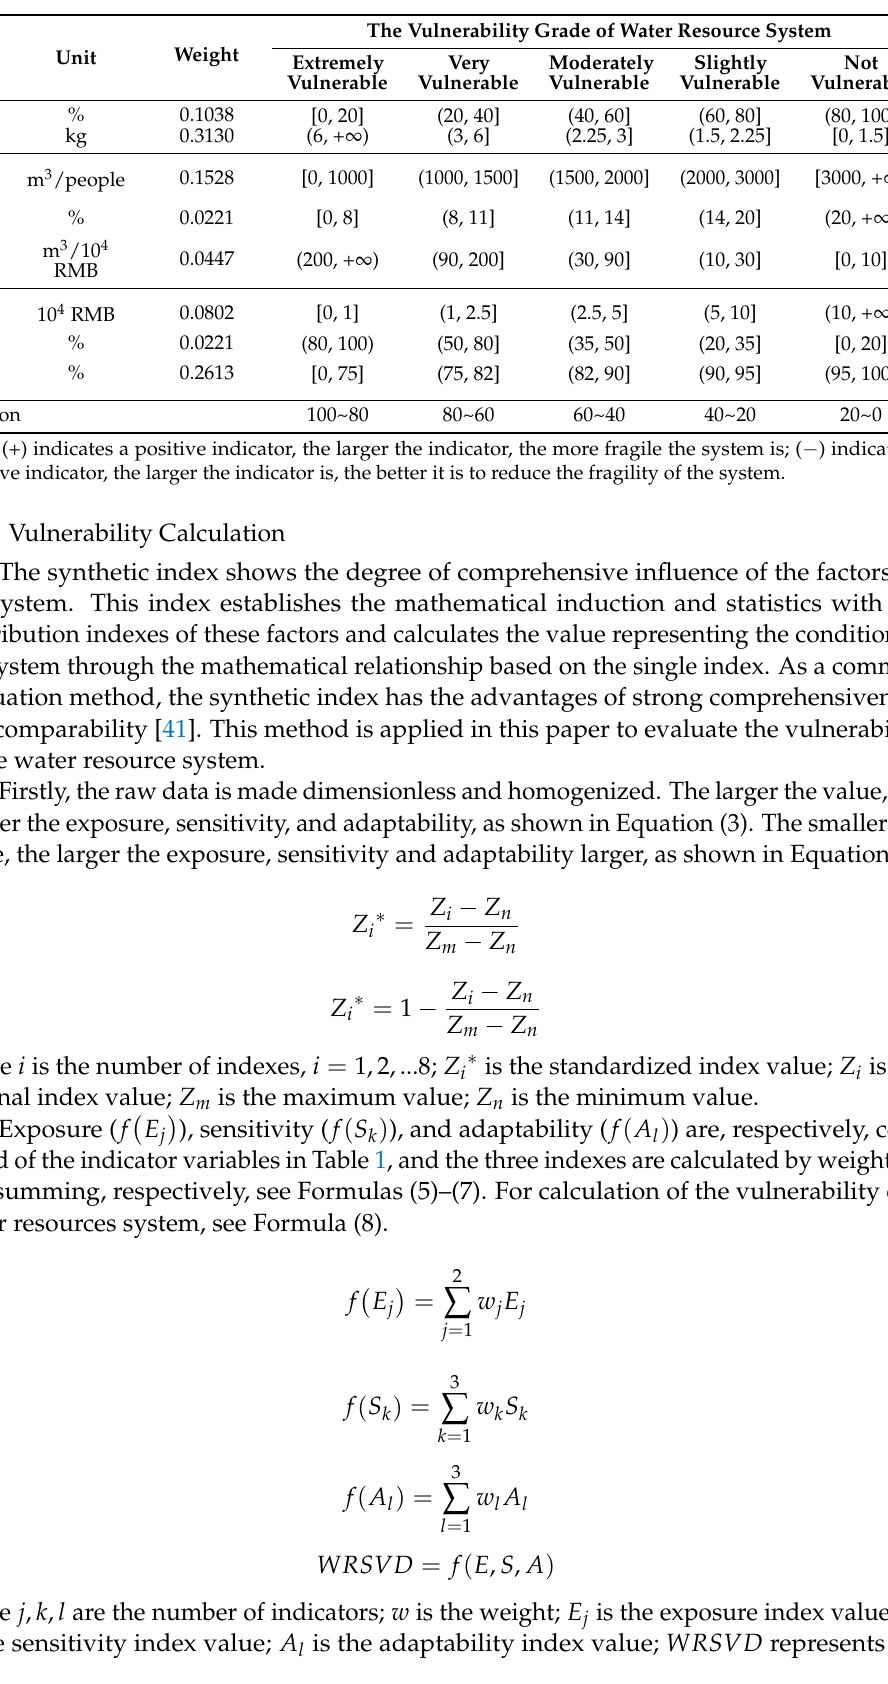
Table 1. Evaluation index scoring criterion and